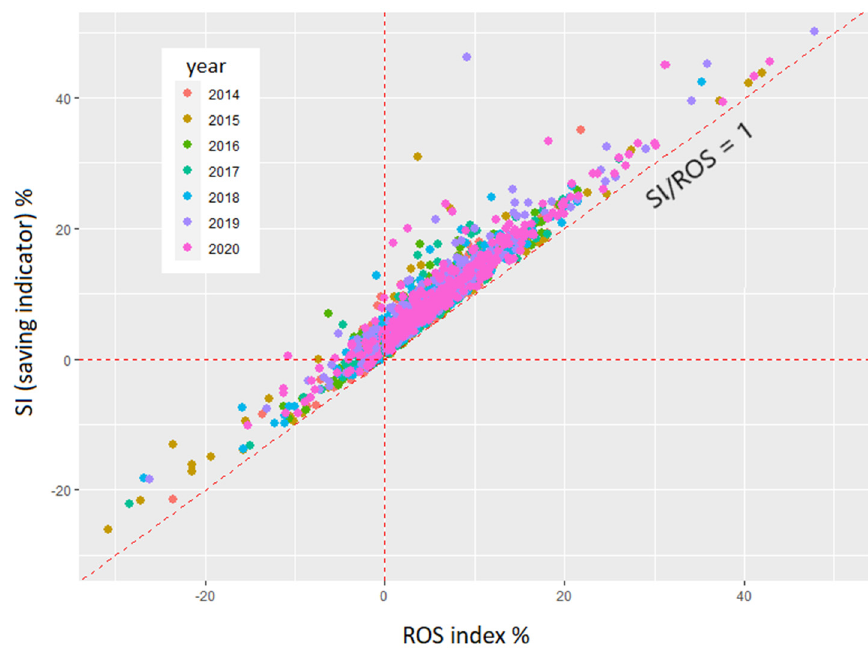
Figure 1. Relationship of the ROS index to SI (powiat level).